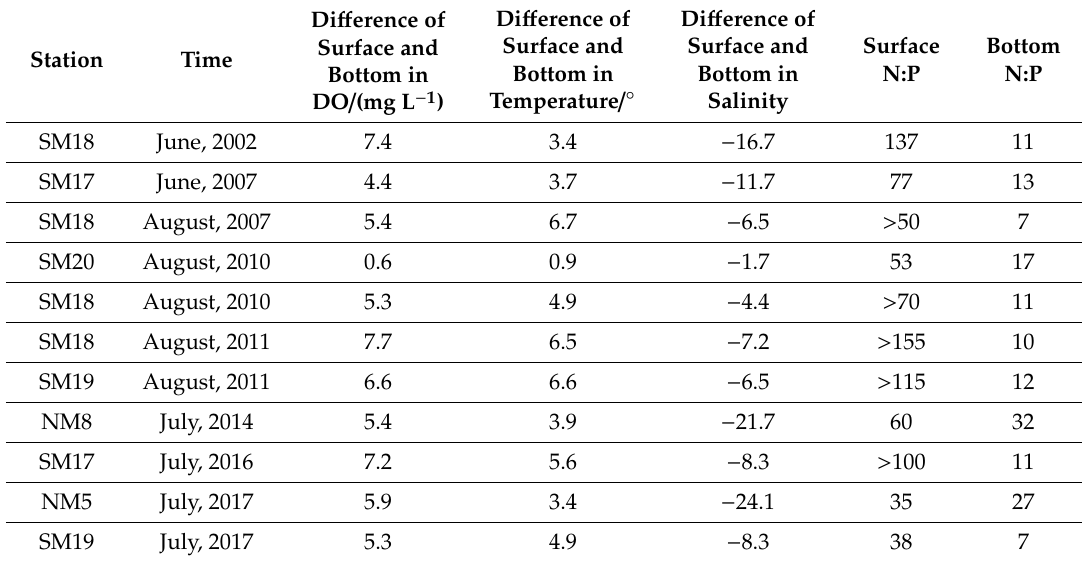
Table 7. Environmental parameters of bottom